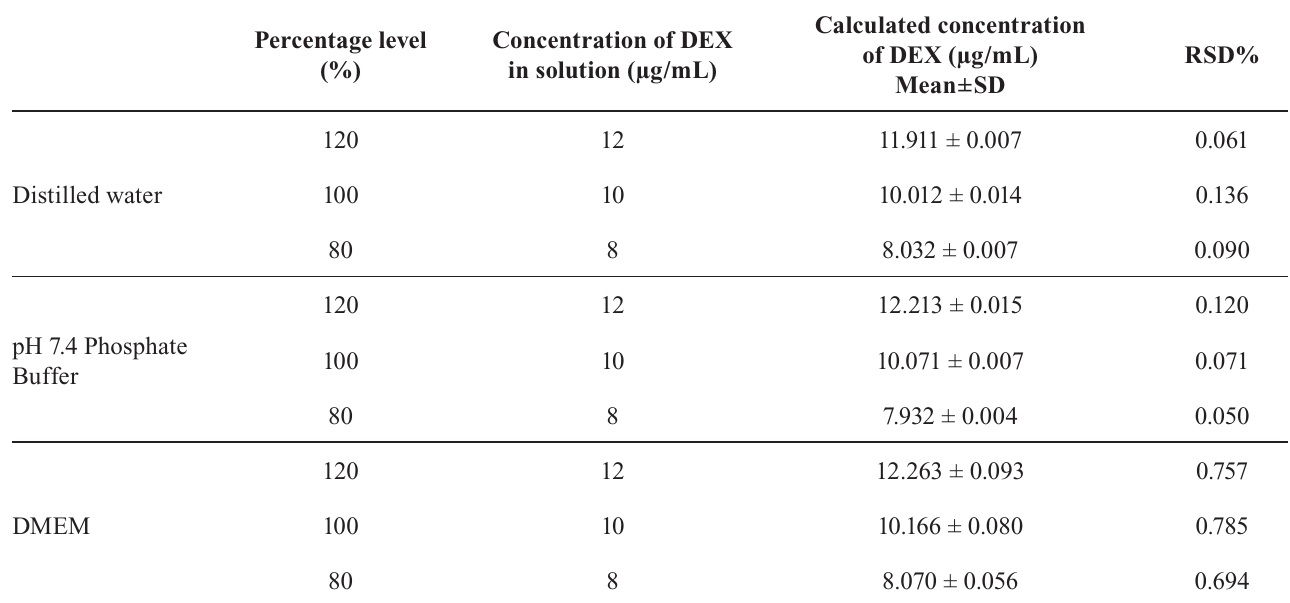
TABLE II - Accuracy and recovery report of dexketoprofen trometamol